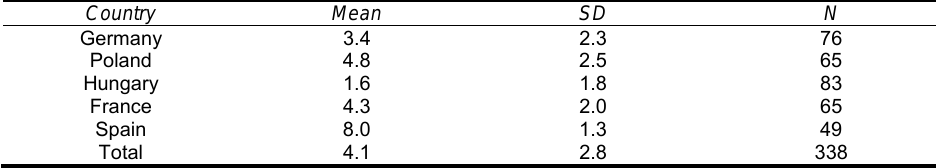
Table 4: National mean values for desired policy competence 22